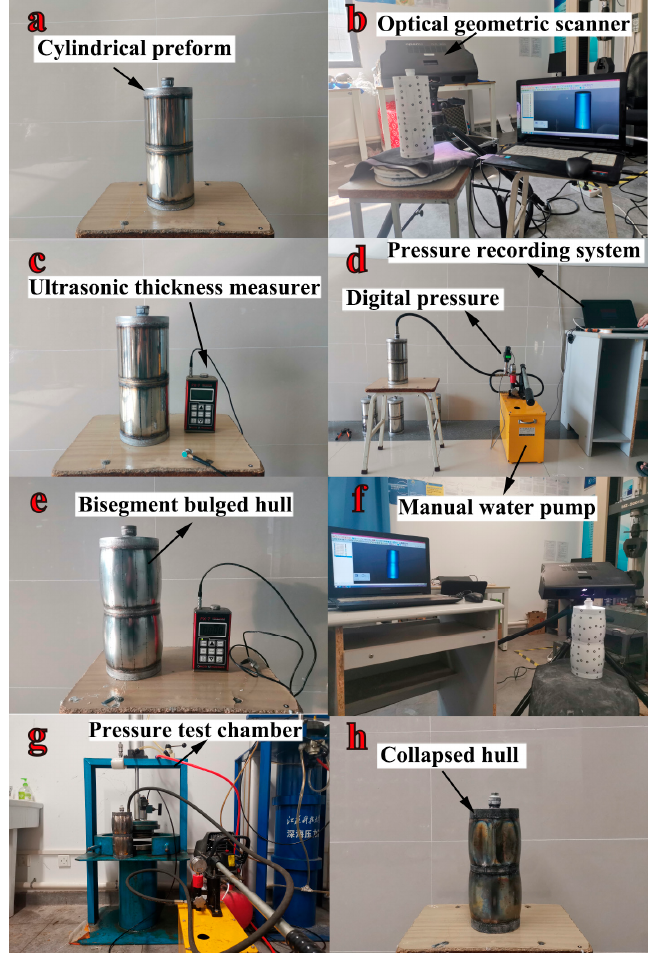
Figure 3. Experimental procedure for buckling of free-bulged bi-segment pressure hulls under external pressure.